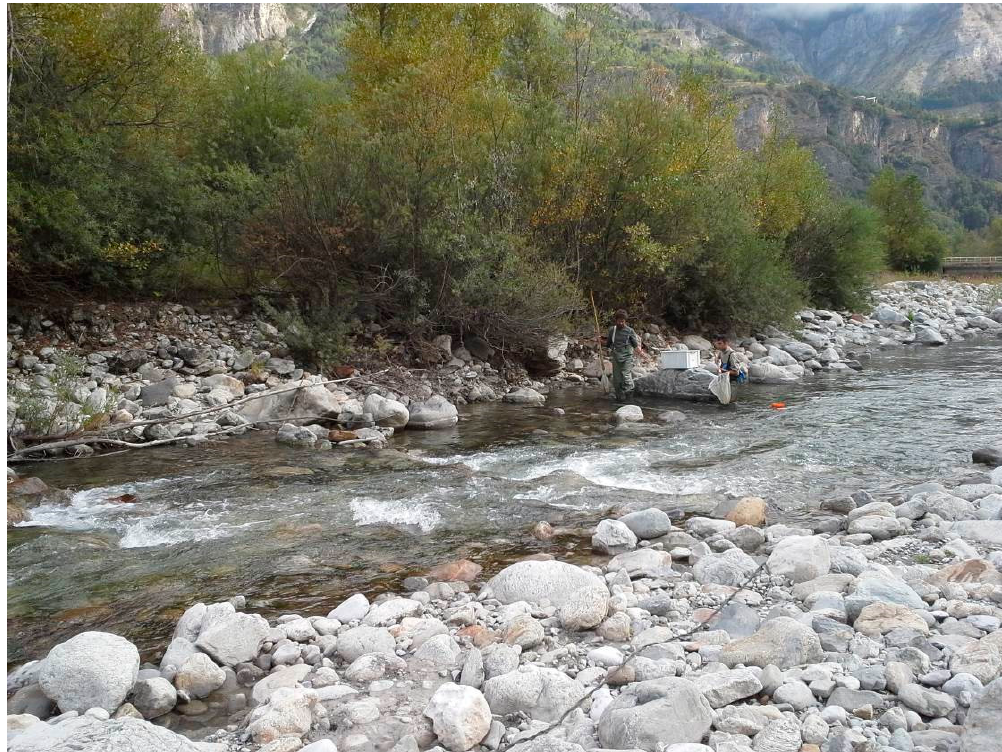
Figure 2. Electrofishing in rapids on the Stura di Demonte River, September 2014.